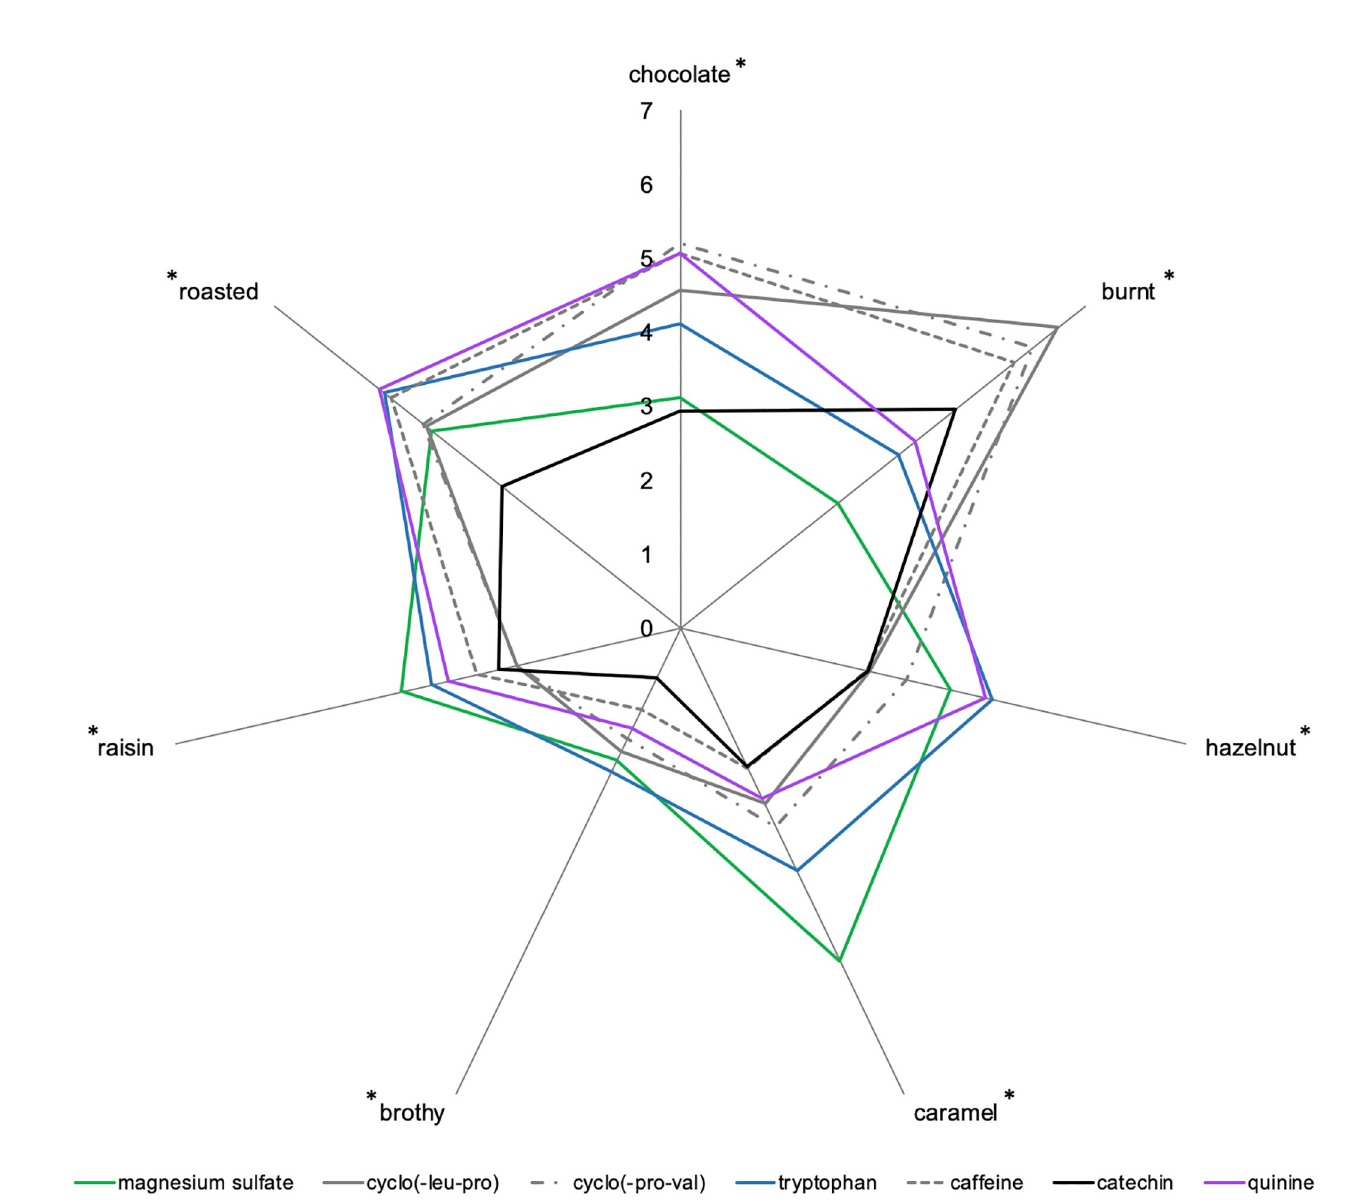
Fig 6. Retronasal descriptive analysis of coffee aroma attribute intensities in seven bitter compounds. � indicates significant impact of bitter compounds on aroma attribute intensity ( α = 0.05).